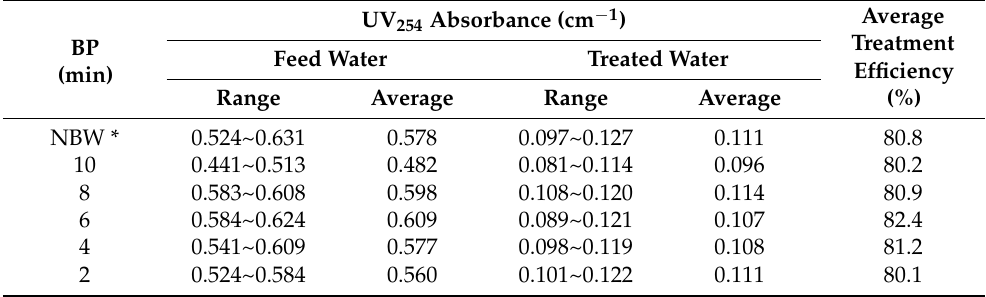
Treatment Efficiency